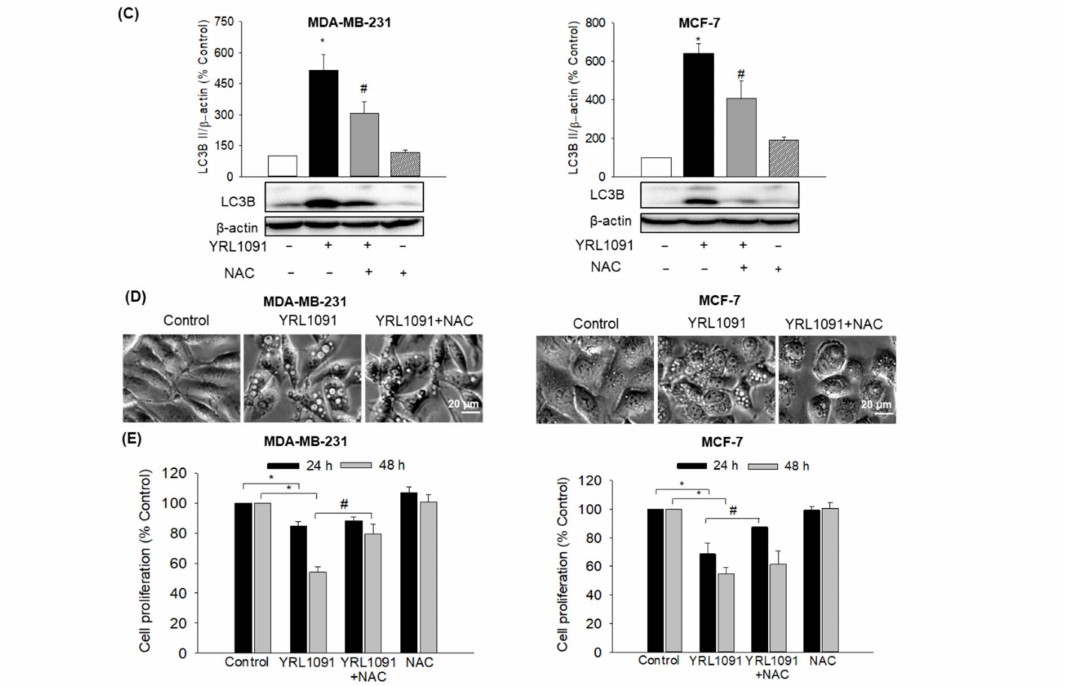
Figure 8. Involvement of YRL1091-induced ROS production in cytoplasmic vacuolization and cell death in MDA-MB-231 and MCF-7 cells. ( A ) Cells were challenged with YRL1091 at 10, 30, and 100 µ M for 12 h. Intracellular ROS levels were quantified by DCFH-DA assay as described in Materials and Methods. Representative fluorescence microscopic images were shown. ( B ) Cells were pretreated with 10 mM NAC for 2 h, followed by exposure to 30 µ M YRL1091 for 12 h. Intracellular ROS levels were caculated as the pecentages of those mesured in vehicle-treated control cells. ( C ) Cells were treated as described in ( B ) for 24 h and subjected to western blotting for LC3B. Each data point was calculated as the percentage of protein level in vehicle-treated control cells. Representative blots were presented. ( D ) Phase-contrast images were obtained after 12 h of treatment. Scale bar: 20 µ m. ( E ) Cell viability was determined by SRB assay at 24 and 48 h. The cell viability of each treated group was expressed as the percentage of that in control group. Data are displayed as the mean ± SEM from at least three independent experiments. * p < 0.05 vs. vehicle-treated control cells; # p < 0.05 vs. YRL1091-treated